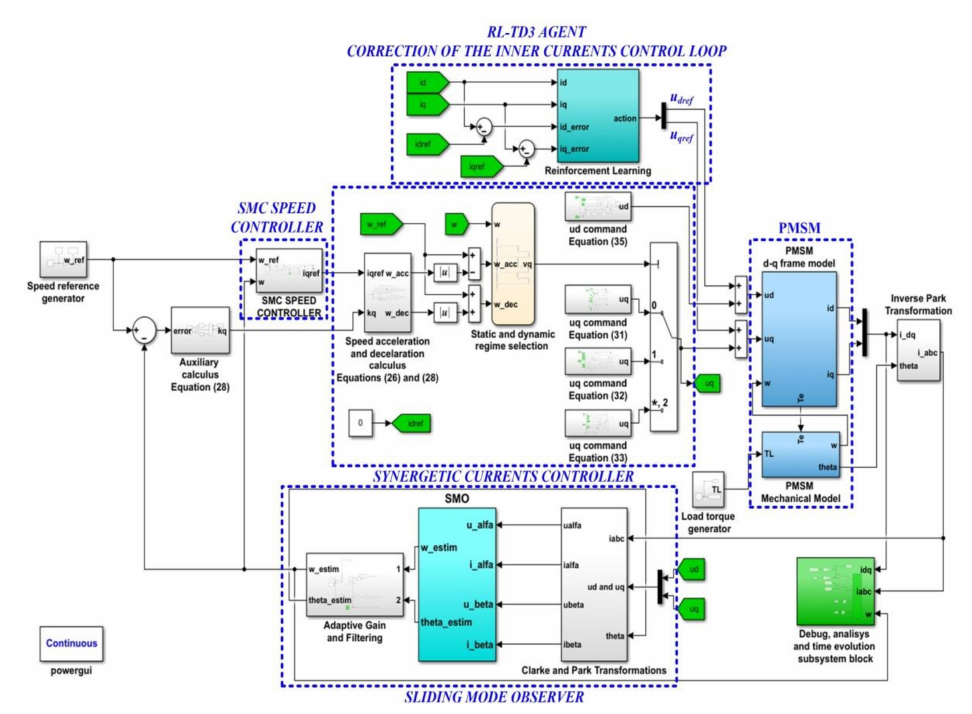
Figure 24. Block diagram of the MATLAB/Simulink implementation for the PMSM control based on SMC and synergetic controllers using the RL-TD3 agent for the correction of u dref and u qref . The training time for this case is 10 h, 29 min, and 14 s. The graphical results for the training stage of the RL-TD3 agent for the correction of u dref and u qref are shown in Figure 25.